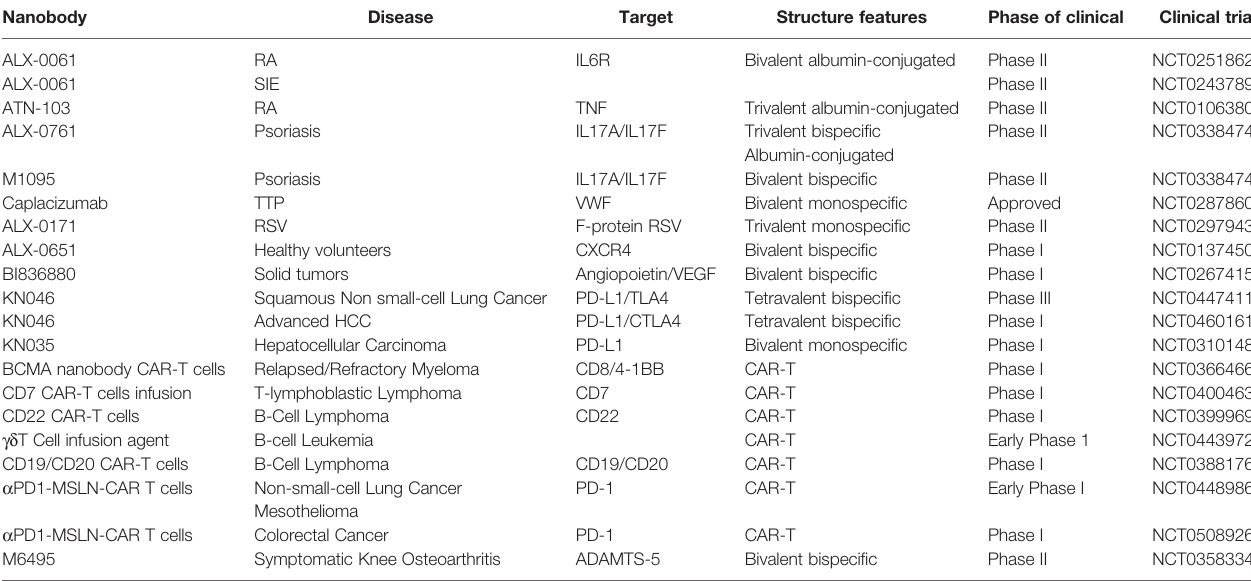
TABLE 1 | Multivalent/bispeci fi c nanobodies that entered clinical trials.